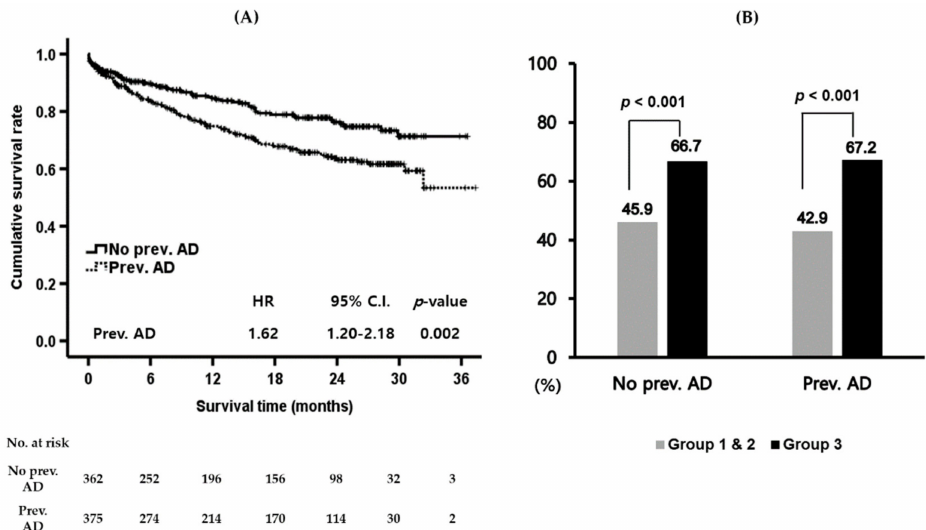
Figure 3. Long-term transplant-free overall survival of patients according to the presence of a previous AD history. ( A ) Long-term transplant-free overall survival was significantly di ff erent between the two subgroups according to the presence of a previous AD history in groups 1 and 2 as a whole (HR 1.62, 95% C.I. 1.20–2.18, p = 0.002). ( B ) Regarding one-year mortality, group 3 showed a poorer outcome compared to group 1 & 2 regardless of a previous AD history ( p < 0.001). AD, acute decompensation; C.I., confidence interval; HR, hazard ratio; No.,